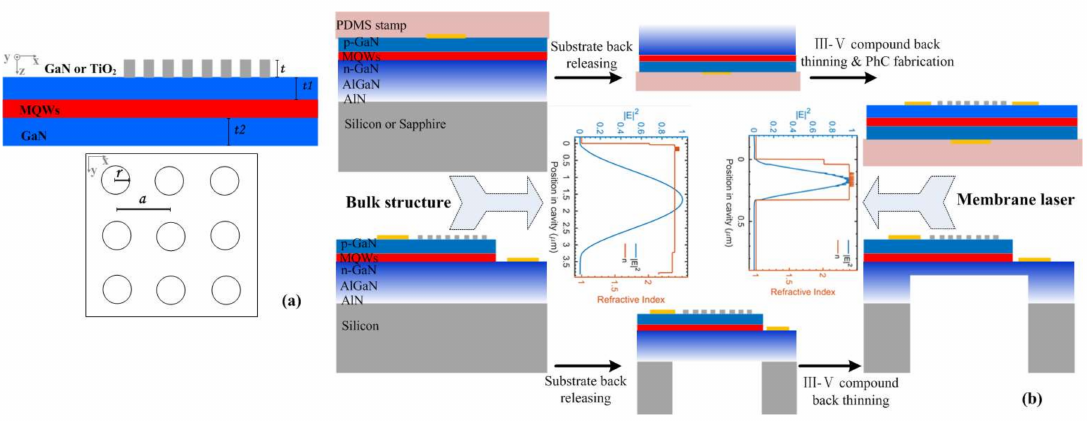
Figure 1. ( a ) Schematics of the proposed GaN membrane PCSEL structures and ( b ) the fabrica- tion process. The figure denotes the bulk wafer structure and the calculated fundamental mode distribution with t 1 = t 2 = 100